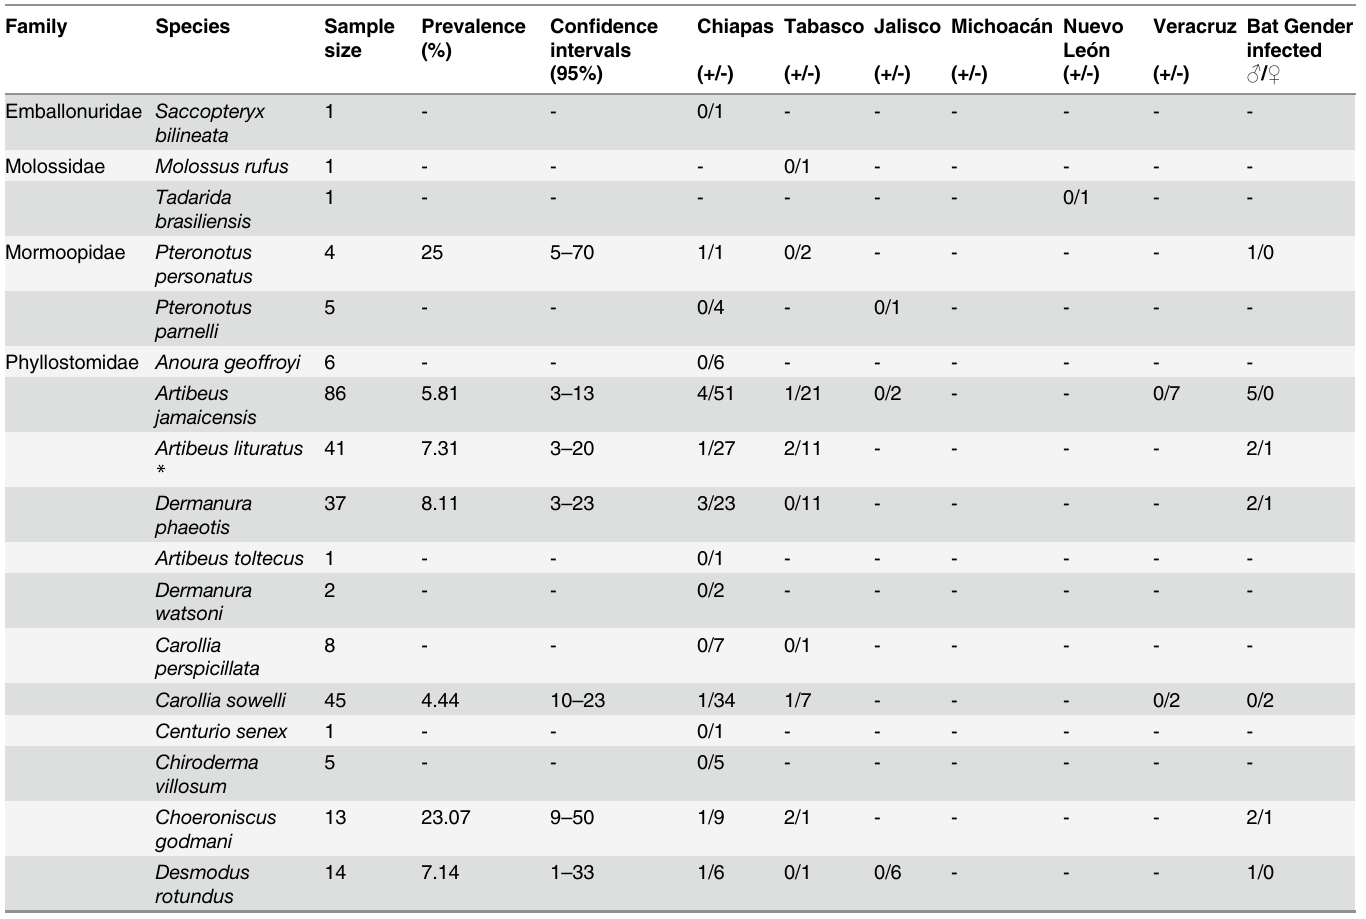
Table 2. Species and family of bats netted in different Mexican states. Family Species